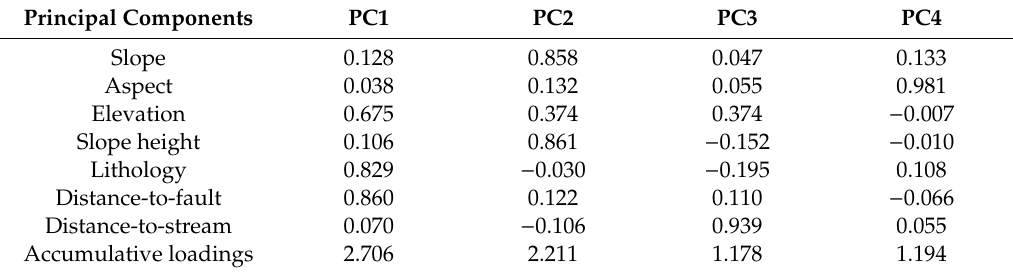
Table 3. Rotated component loadings of the indicators on selected principal